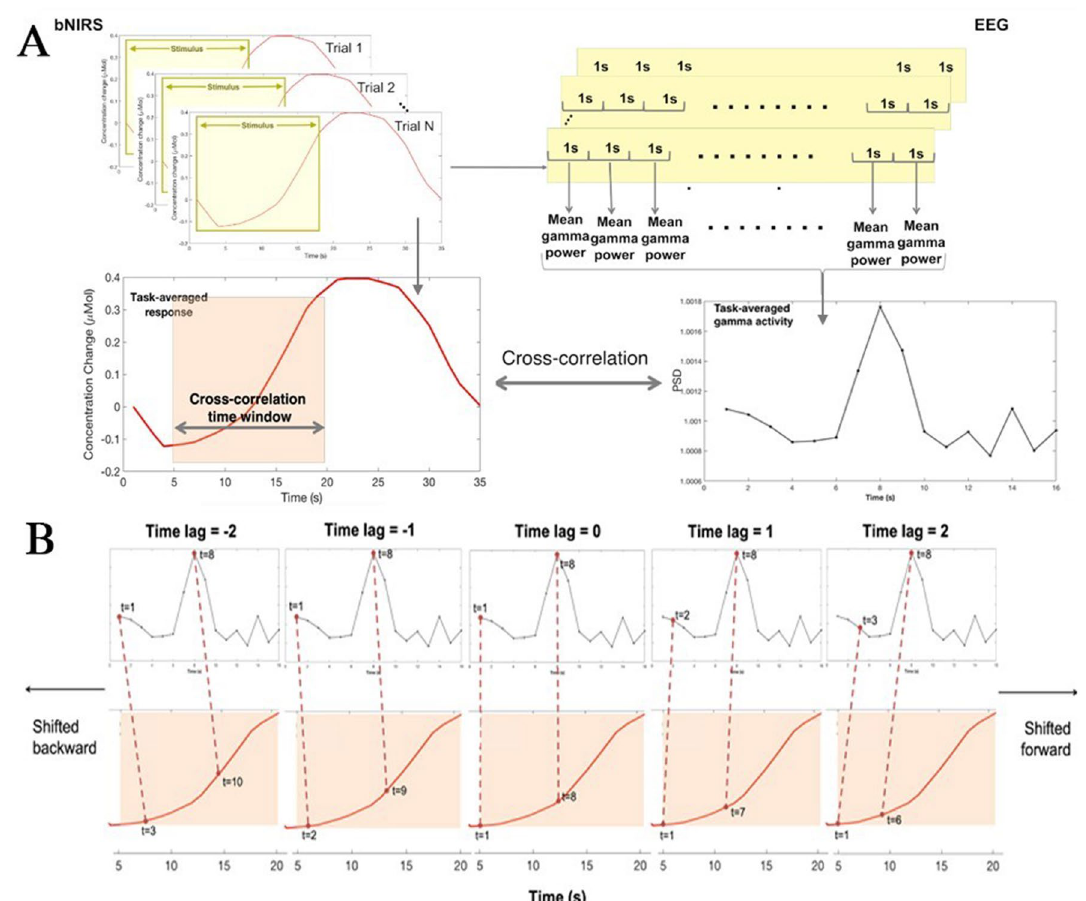
Figure 11. Procedure for combining the bNIRS and EEG data. ( A ) An EEG measure (mean gamma power across the task period) is derived from the EEG data that is used to cross-correlate with the bNIRS signals. The data shown here is from a single subject for the purposes of outlining the analysis procedure. ( B ) The procedure for calculating cross-correlations is demonstrated for the EEG and the NIRS data from time window 5–20 s, for selected time points, for illustrative purposes. For the positive time-lags, the cross-correlation is performed by shifting the NIRS signal forward with respect to the EEG for each time-lag. For example, for time-lag = 1, EEG time point t = 2 is correlated with bNIRS signal time point t = 1. For time-lag = 2, EEG time point t = 3 is correlated with bNIRS signal time point t = 1, i.e. the bNIRS signal is shifted forward for each positive time-lag. For the negative time-lags, the bNIRS signal is shifted back such that at time-lag = -1, EEG time point t = 1 is correlated with bNIRS time point t = 2. For time-lag = − 2, EEG time point t = 1 is correlated with bNIRS time point t = 3, i.e. the bNIRS signal is shifted backwards for each negative gamma power during the task with respect to the baseline. Only the electrodes that were statistically significant (p < 0.05; FDR corrected for multiple comparisons) were included in this analysis. The bNIRS data were up-sampled to 1 s and cross-correlations between the task-averaged bNIRS signals (HbO 2 , HHb and oxCCO) and the EEG measure were performed using a sliding window approach. More spe- cifically, the EEG measure was cross correlated with 15 s of the bNIRS signals in time windows from 1 – 16 s to 10 – 25 s in 1 s increments. This yielded 10 time windows of cross-correlations. In the current analysis, the bNIRS channels were correlated with selected EEG electrodes that were located over the occipital, parietal and central-parietal regions and nearest to the bNIRS optodes. These channels have been indicated on Fig. 9B with orange circles. Cross-correlations provide a measure of similarity between two time series where one time series x(t) may be related to another time series y(t) by a set time-lag or time-delay. At each time-lag, to obtain the cross-correlation between the two time-series, y(t) is shifted along and correlated with x(t) at each time point to obtain a correlation at each time-lag. Correlations are calculated both for positive and negative time-lags. In order to obtain positive time-lags, y(t) is shifted forward with respect to x(t) and to obtain negative time-lags, y(t) is shifted backwards with respect to x(t). The cross-correlation for time series x(t) and y(t) (where t = 0, 1, 2,…, N) is calculated using the following formula with the time-lag equal to d .